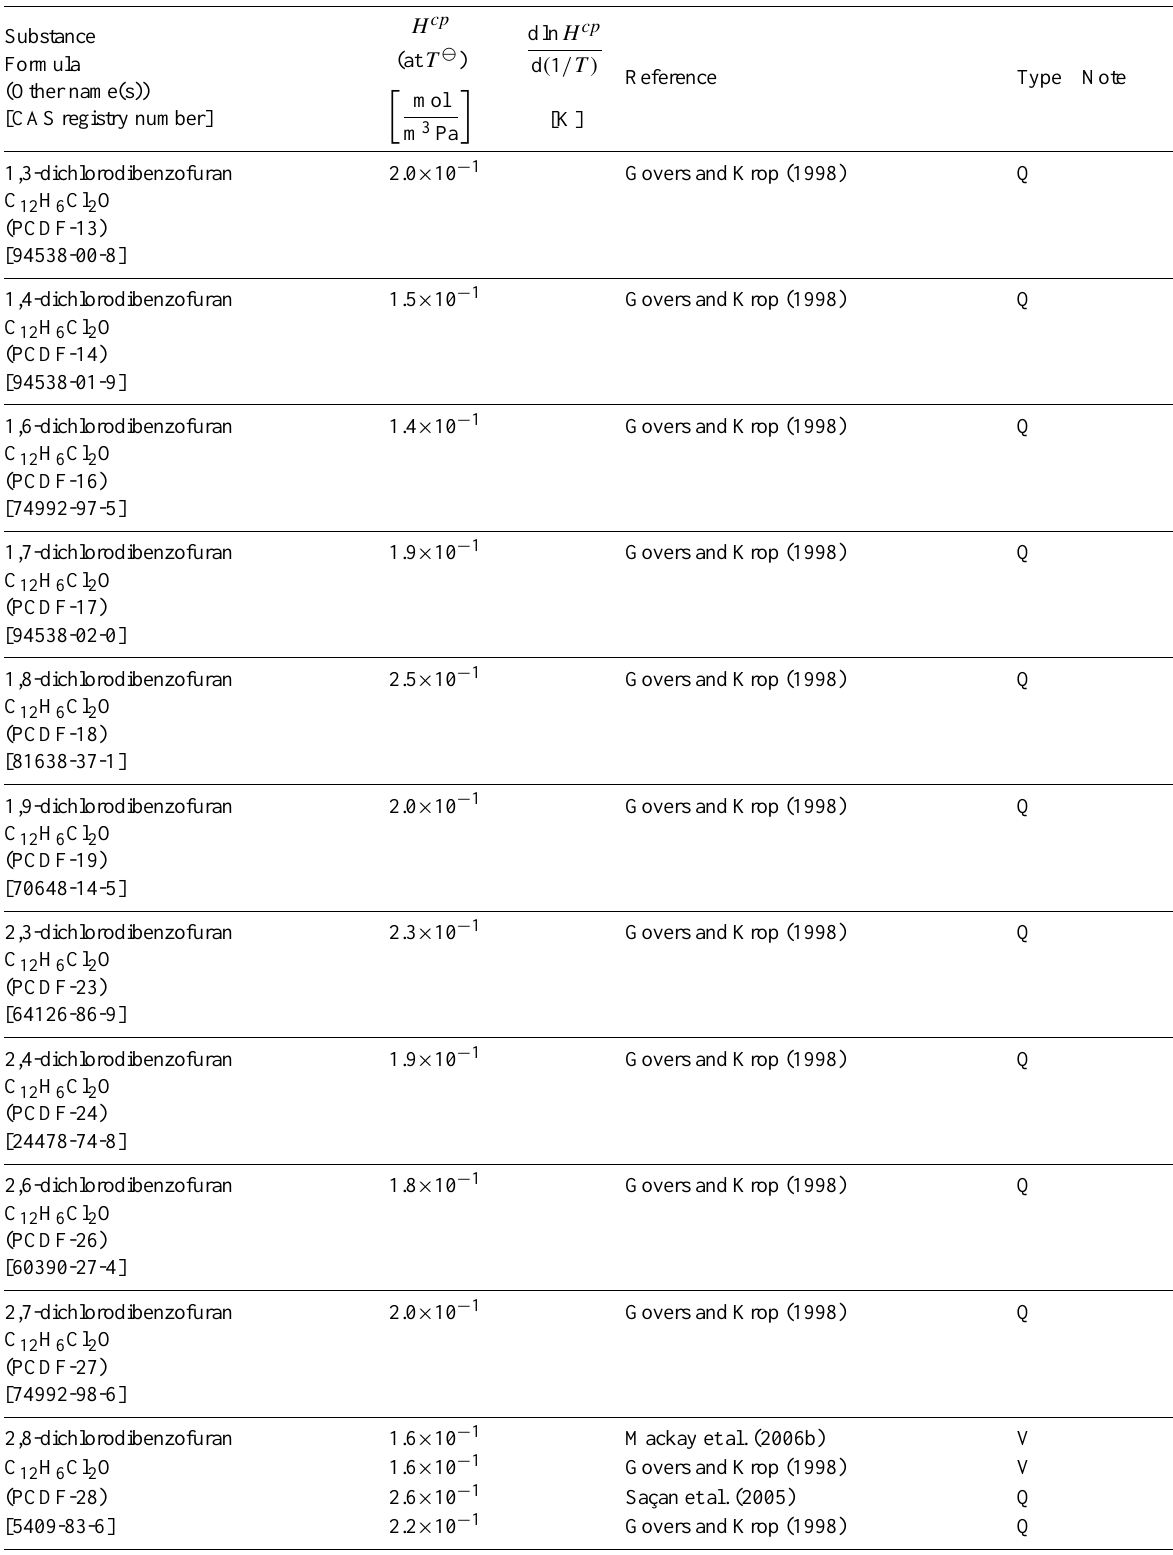
Table 6: Henry’s law constants for water as solvent